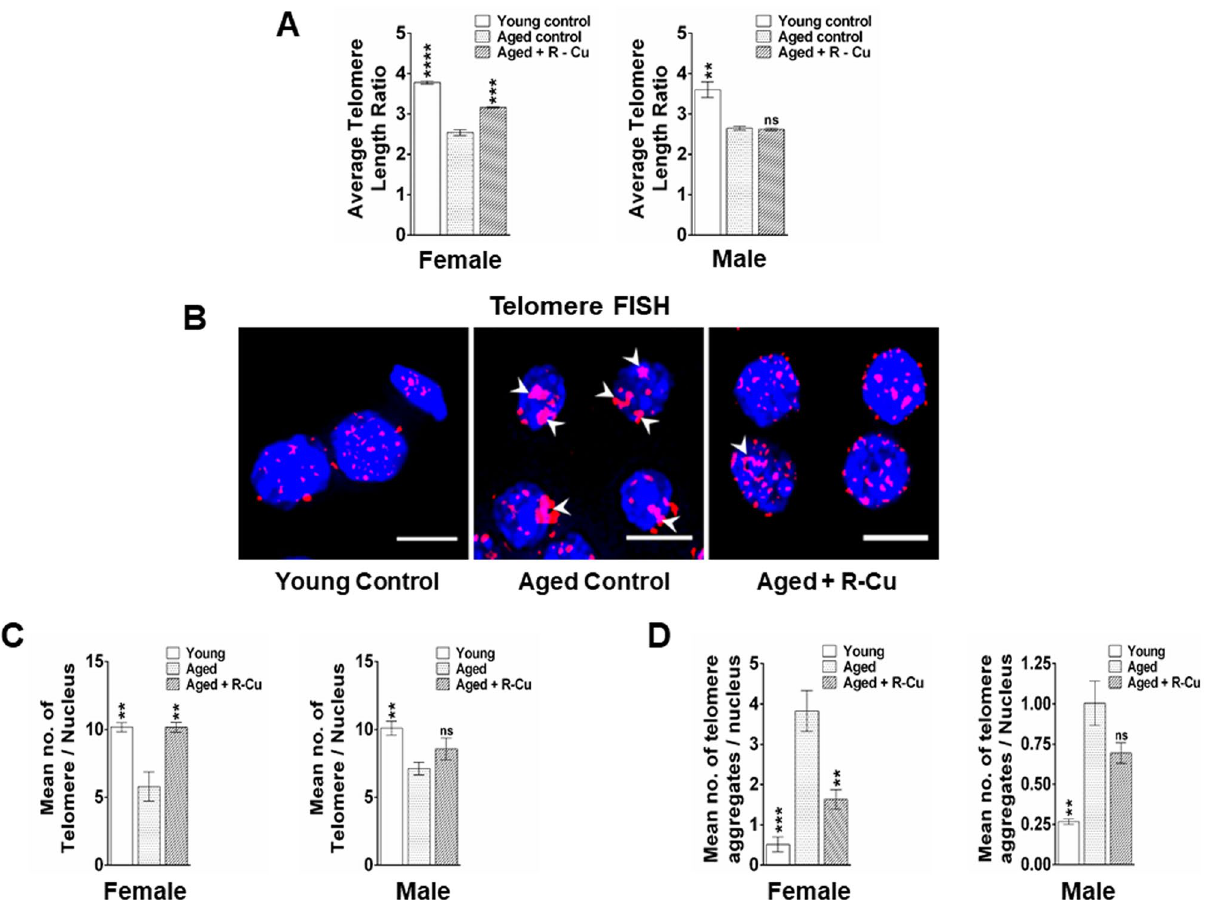
Figure 3. Telomere abnormalities in brain cells of ageing mice and their prevention by treatment with R–Cu. ( A ) Estimation of telomere length by quantitative RT-PCR. Bars represent mean ± SEM values. N = 4 animals of both sexes, except in R–Cu treated female mice wherein N was = 3; ( B ) Representative images of telomere FISH (Scale bar = 10 µm). ( C ) Histograms representing number of telomeres per nucleus as estimated by SpotScan Software 8.1 (https:// spect ral- imagi ng. com, Applied Spectral Imaging, Israel). Mean number of fluorescent telomere signals per nucleus from five randomly chosen fields (~ 500 nuclei) is represented in the histograms. Bars represent mean ± SEM values. N = 4 animals each group of both sexes; ( D ) Histograms representing telomere aggregates per nucleus (marked by arrow heads in B ). Mean number of fluorescent telomere aggregates per nucleus from five randomly chosen fields (~ 500 nuclei) is represented in the histograms. Bars represent mean ± SEM values. N = 4 animals each group of both sexes. In ( A,C,D ) values in young controls and R–Cu treated ageing mice were compared with those of ageing controls, and statistical analysis was performed by two- tailed Student’s t test. ** p < 0.01; *** p < 0.001; **** p <